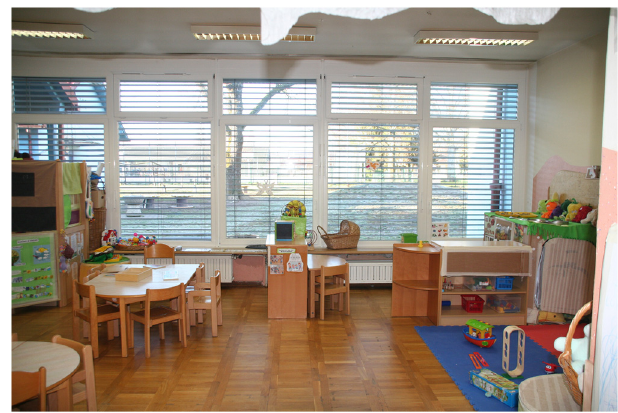
Figure 1. Kindergarten classroom, 2A measured interval.